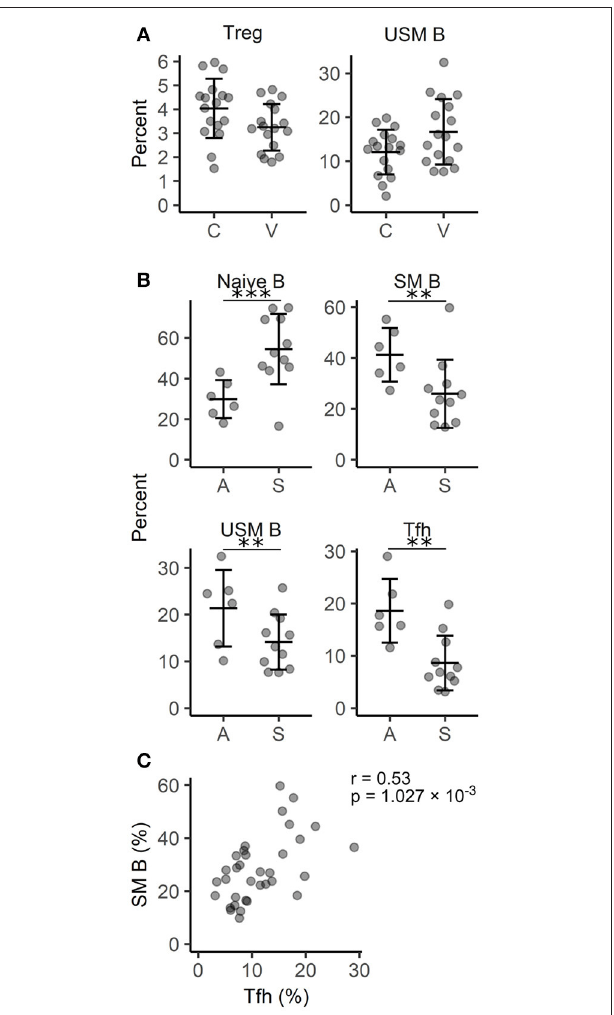
FIGURE 4 | Comparison of circulating lymphocyte subpopulations in vitiligo patients with different disease activity. (A) The percentage of regulatory T cells (Treg) among T helpers and unswitched memory (USM) B cells among B cells in vitiligo patients (V) and control individuals (C). (B) The percentage of naïve, switched memory (SM) and USM B cells among B cells and follicular helper T cells (Tfh) among T helper cells in vitiligo patients with active (A) Vs. stable (S) disease. Arithmetic mean ± standard deviation is indicated. * p < 0.05; ** p < 0.01; and *** p < 0.001. (C) A scatter plot showing the correlation between the percentages of SM B cells and Tfh cells. Pearson’s correlation coefficient (r) and the p -value of the association test are indicated on the